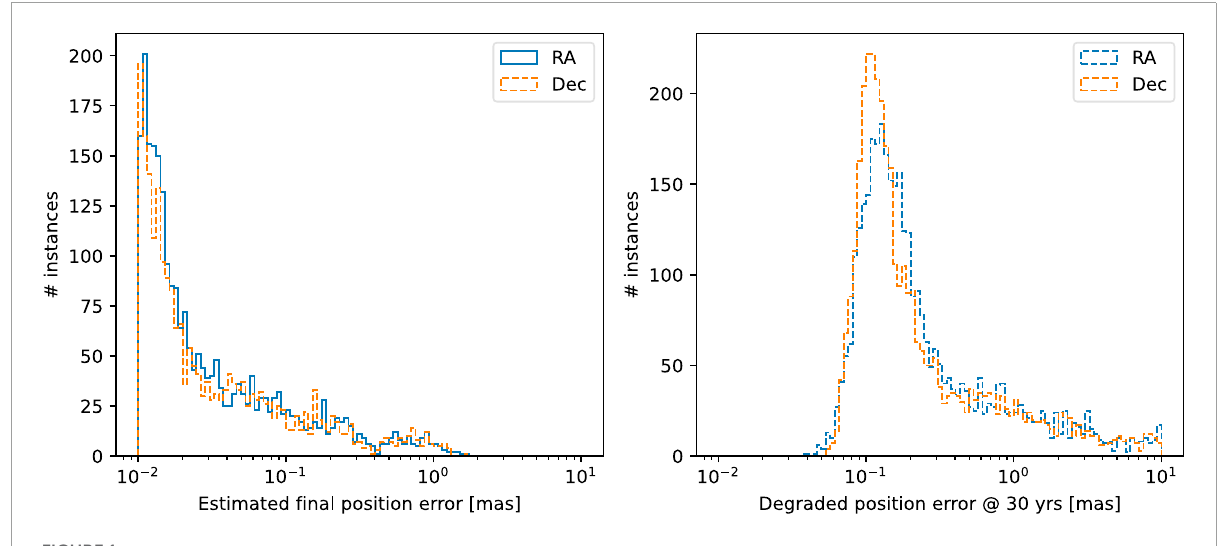
FIGURE 1 Estimated position errors at the end of mission for stars within 20 pc (left), from the Gaia EDR3 catalogue extrapolated to the end of mission, and natural degradation after 30 years due to proper motion